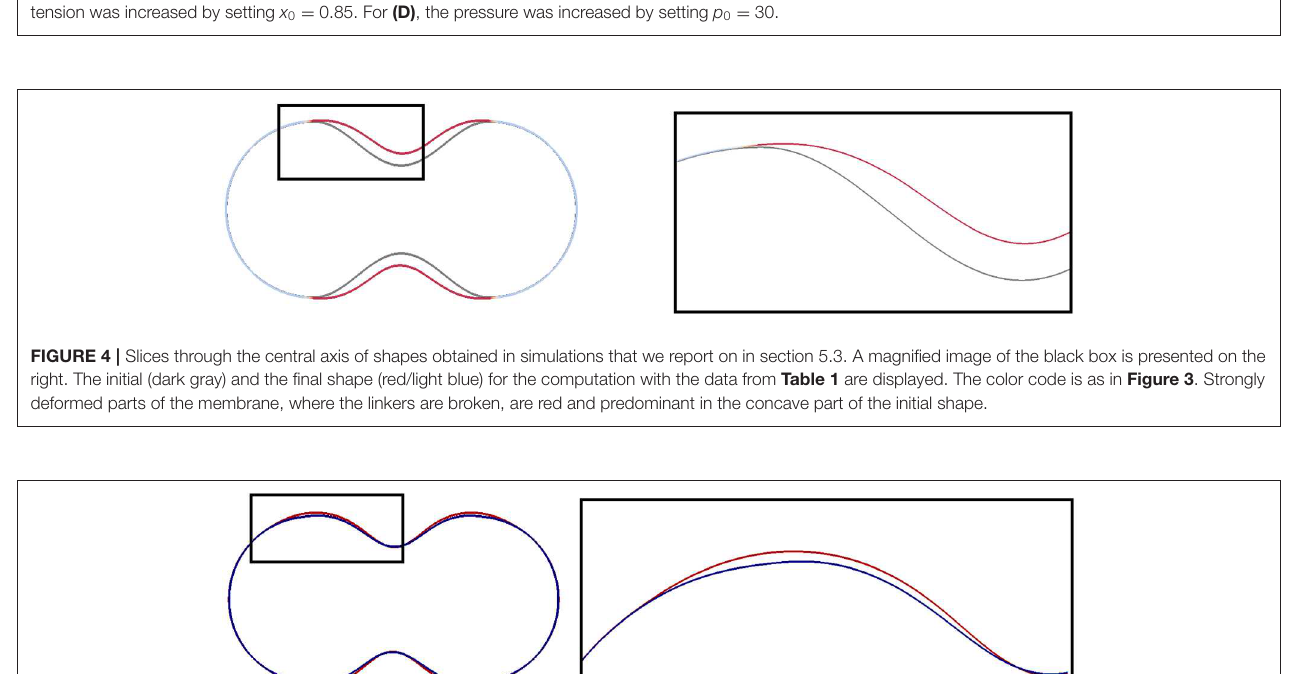
FIGURE 3 | Final shapes for computations with the initial shape in Figure 2 . The color scheme indicates the distance of the membrane to the cortex Values below the resting length l 0 shaded as indicated on the bar. The parameters in Table 1 lead to the upper left shape (A) . For (B) , the linker strength was reduced by setting λ l tension was increased by setting x 0